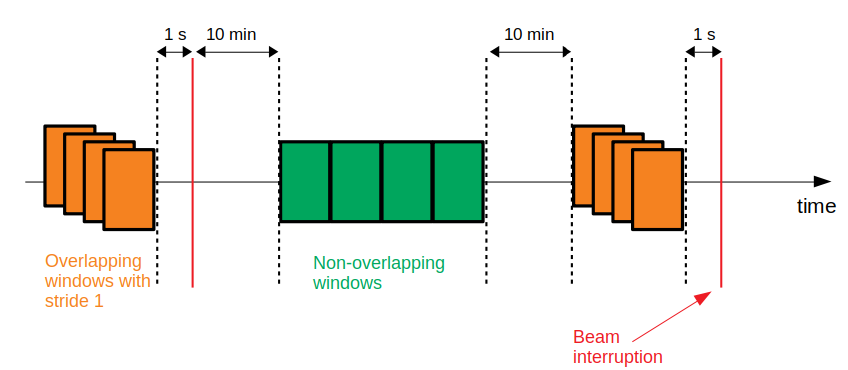
Figure 5. Definition of interlock windows (orange) and stable windows (green). 5 overlapping interlock windows are cut at 1 s before the interlocks, and non-overlapping stable windows are cut in between two interlocks with a 10-min buffer region. Each window has a length of 12.8 s (64